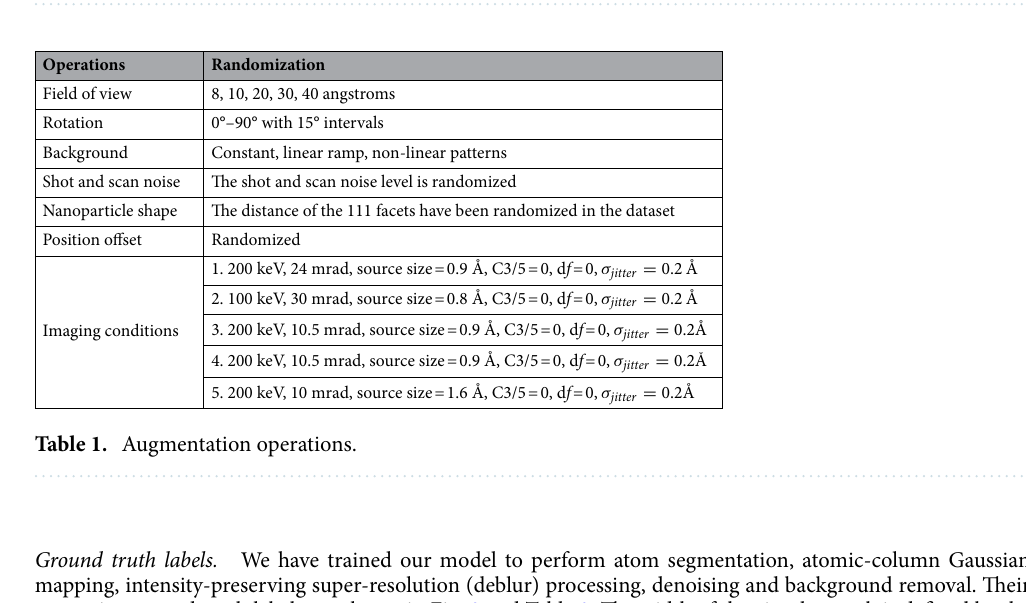
Figure 1. Synthetic images. ( a ) Images created by the simple linear imaging forward model with ( b ) synthetic shot and ( c ) scan noises.